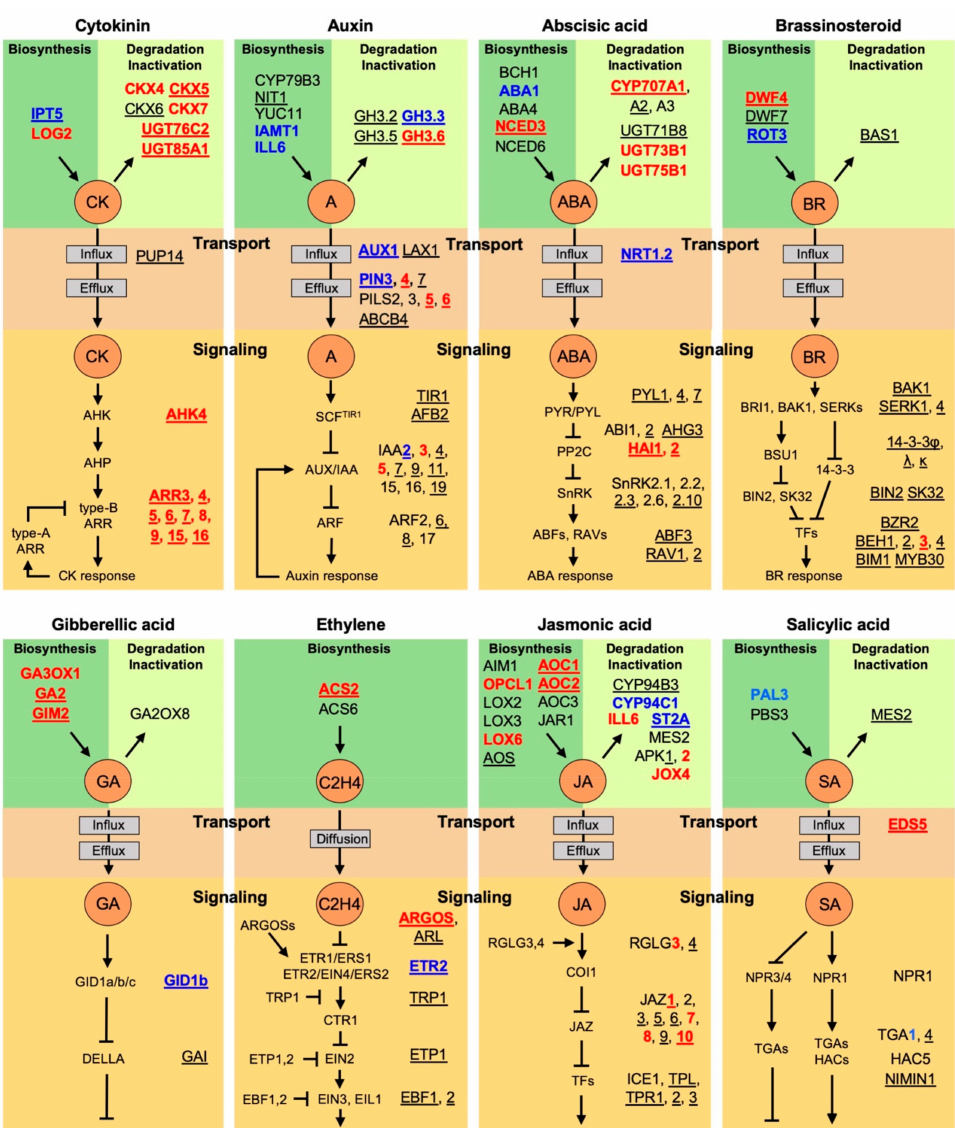
Figure 2. Cytokinin regulates hormone crosstalk through action of the type-B ARRs, pathways by which activity of the phytohormones cytokinin, auxin, abscisic acid, brassinosteroid, gibberellic acid, ethylene, jasmonic acid, and salicylic acid are outlined. Type-B ARR candidate genes involved in hormone biosynthesis, degradation / inactivation, signaling, and transport are indicated based on the Zubo et al. [24] dataset. Genes are underlined if part of the “conserved crosstalk” dataset based on the intersection of the Zubo et al. [24] candidate genes with the Xie et al. [34] “common” candidate genes. Type-B ARR targets confirmed by expression are in bold and highlighted in red if induced by cytokinin or blue if inhibited by